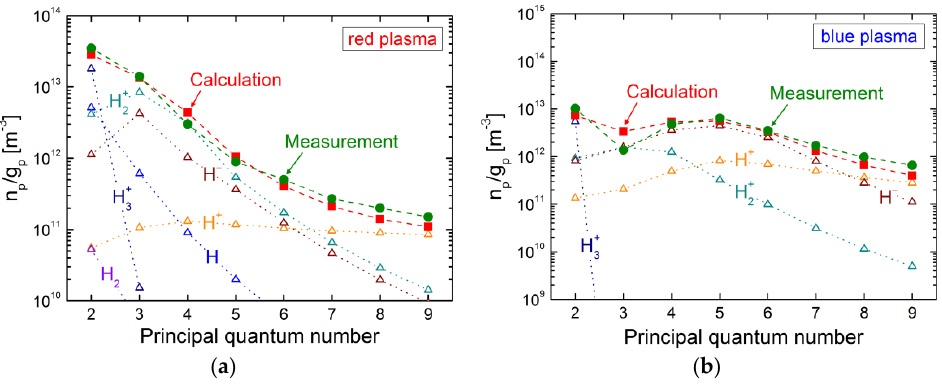
Figure 5. Comparison of population densities in the hydrogen atom (divided by the statistical weight) calculated by the CR model and measured in the plasma of a magnetized plasma expansion: ( a ) partially recombining red part of the plasma; ( b ) fully recombining blue part of the plasma.